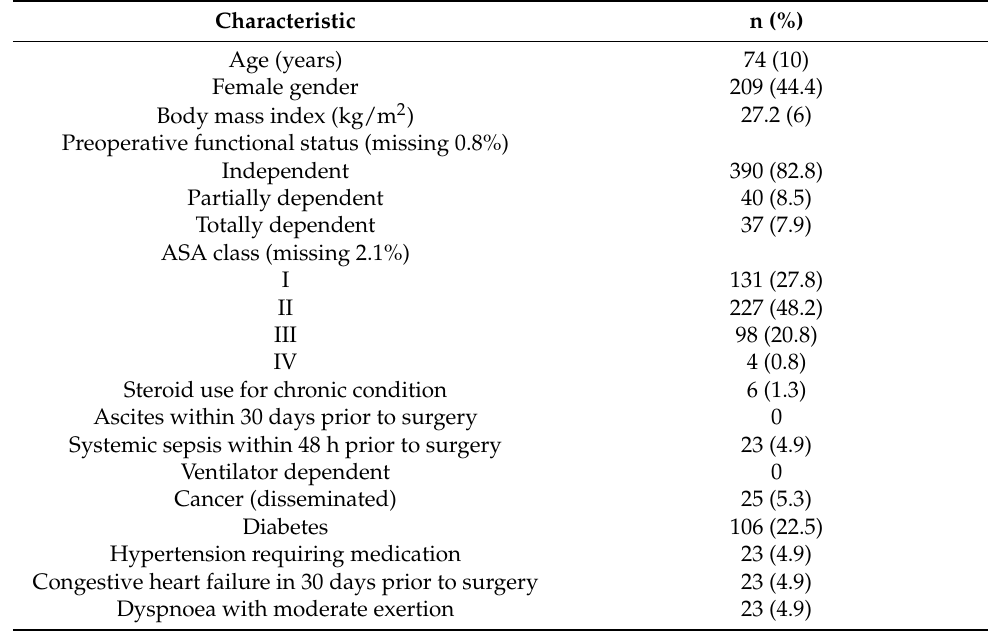
Table 1. Baseline characteristics of 471 elderly patients undergoing general surgery procedures between 2012 and